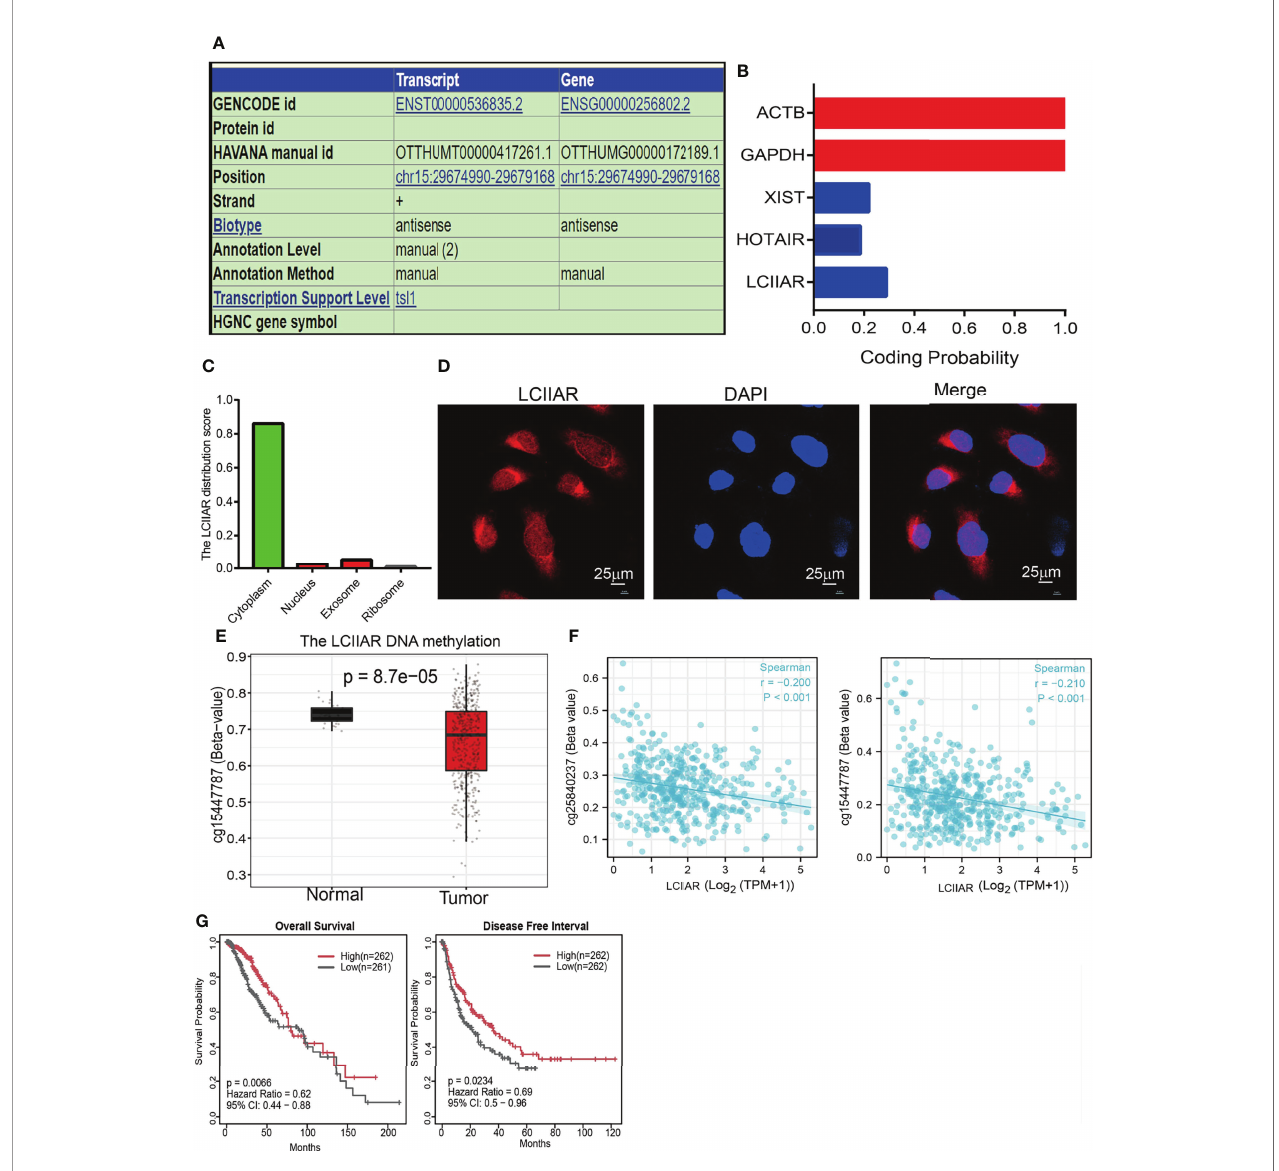
FIGURE 2 | DNA methylation regulated the expression oflncRNA LCIIAR inLUAD. (A) The genomic attributes ofLCIIAR was examined by UCSC database. (B) The coding potential of LCIIAR was examined by CPC2 database. (C) The subcellular localization of LCIIAR was predicted byLncLocater. (D) The sub-cellular localization of LCIIAR was examinedby FISH assay inA549 cells (E) The methylation levels of LCIIAR in lung cancer and normaltissues. (F) The correlation between the methylation level andDNA expression of LCIIAR by SMART database. (G) Kaplan-Meier analysisof OS and DFI for the methylation level of LCIIAR in TCGA LUAD